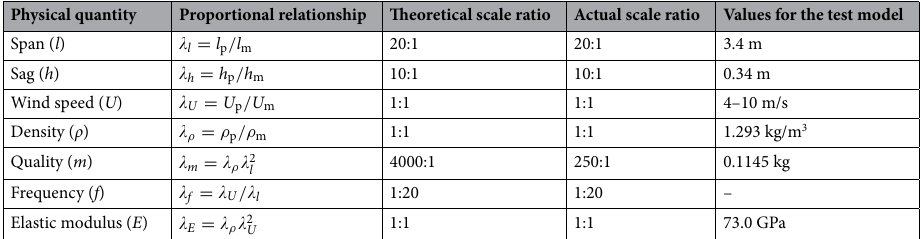
Table 1. Scaling ratios for various physical parameters of the aero-elastic model.